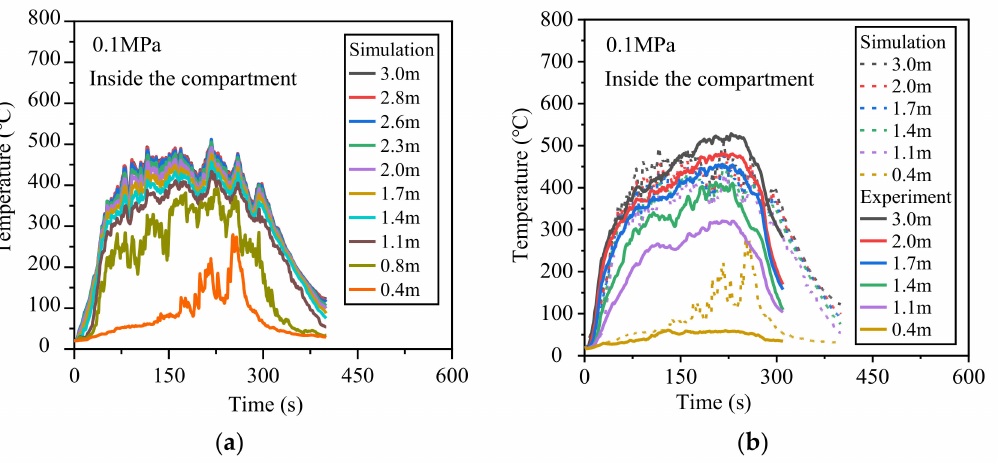
Figure 10. Window sprinkler protection experiment internal temperature at 0.1 MPa operating pressure: ( a ) simulation value, ( b ) comparison with experiment